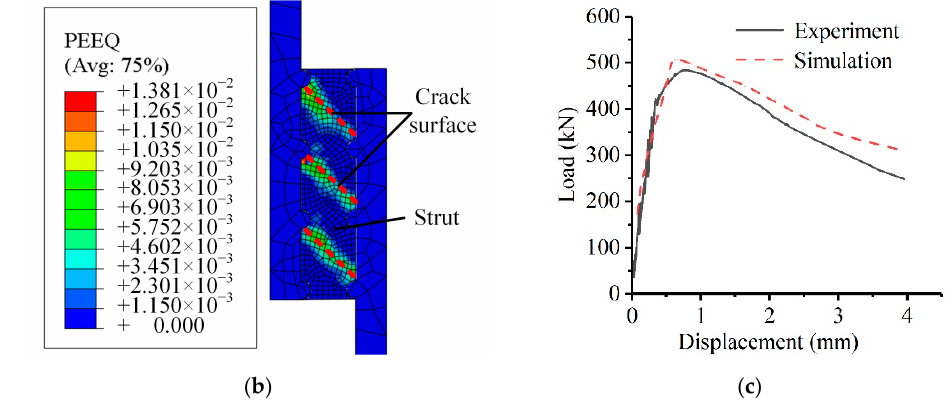
Figure 11. Finite element analysis of 60a: ( a ) model of 60a; ( b ) strain in the sleeve grouting connection; ( c ) Load–Displacement curve.